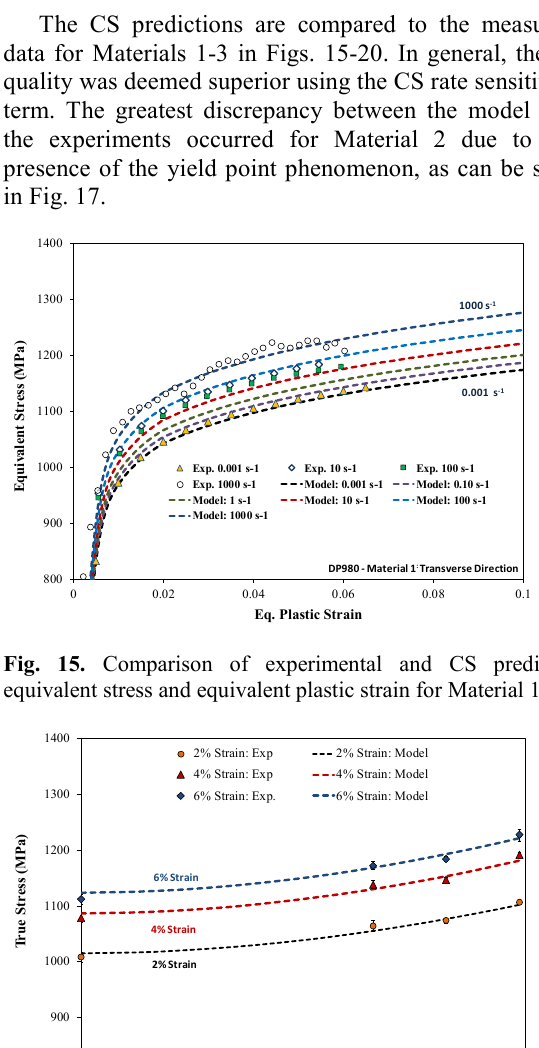
Fig. 14. Experimental rate sensitivity of Material 2 compared to the J-C model predictions.